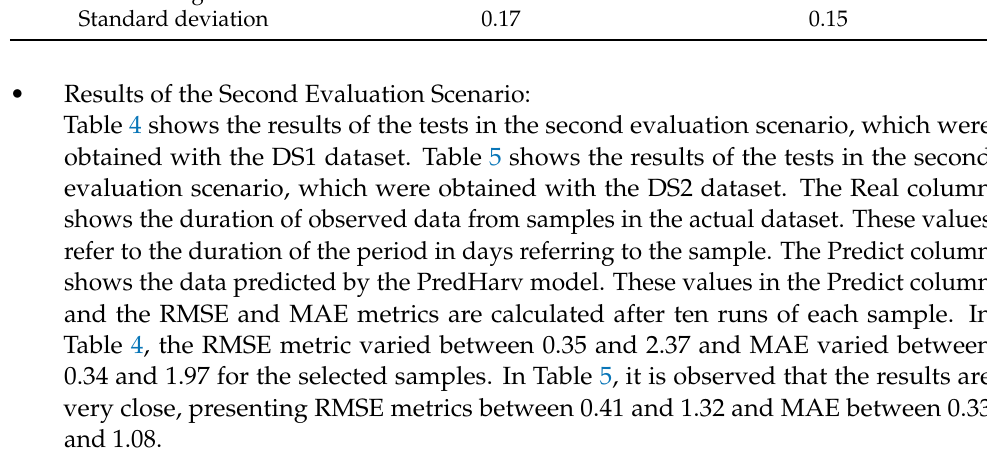
Table 4. Prediction results with the second evaluation scenario—dataset DS1.